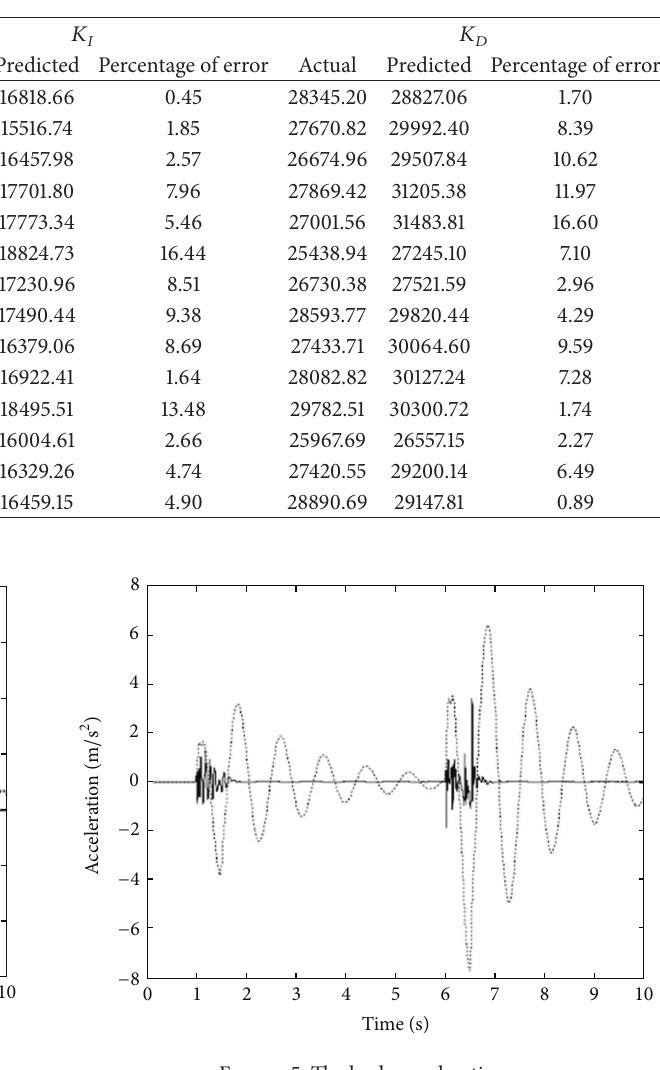
Table 11: Comparison between actual gain parameters of PID and the BPN model (with newff function).